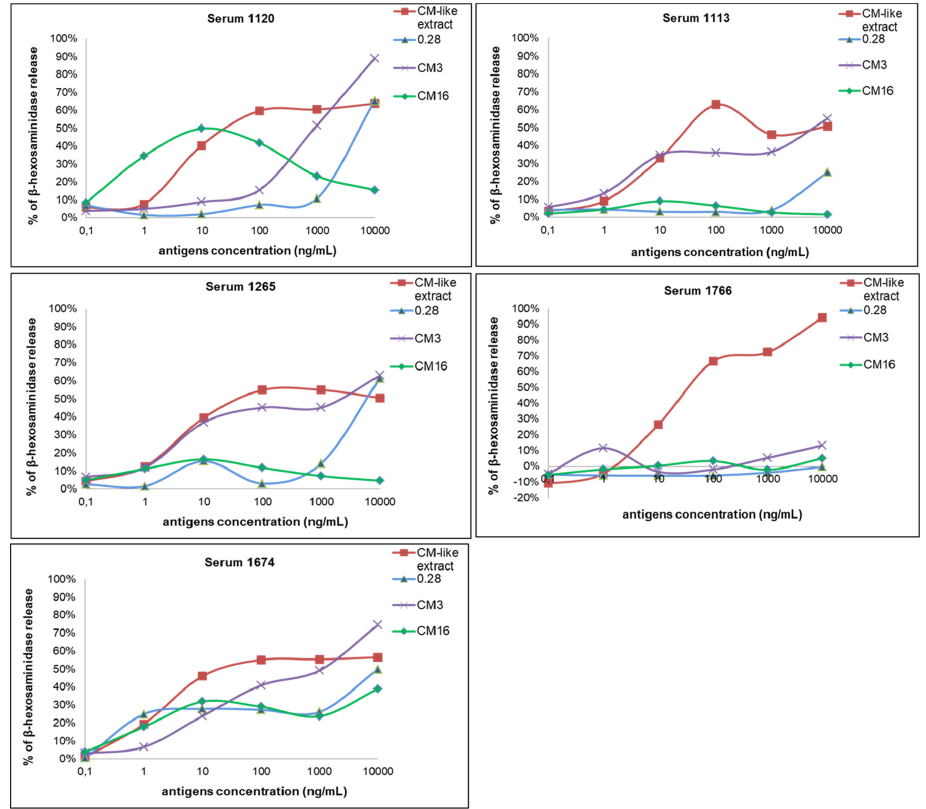
Figure 4. Basophil activation assay with five sera from wheat allergic patients. RBL-SX38 cells were stimulated with concentrations ranging from 0.1 to 10.000 ng/mL of CM3, 0.28, CM16 proteins and of CM-like extract from Bobwhite.